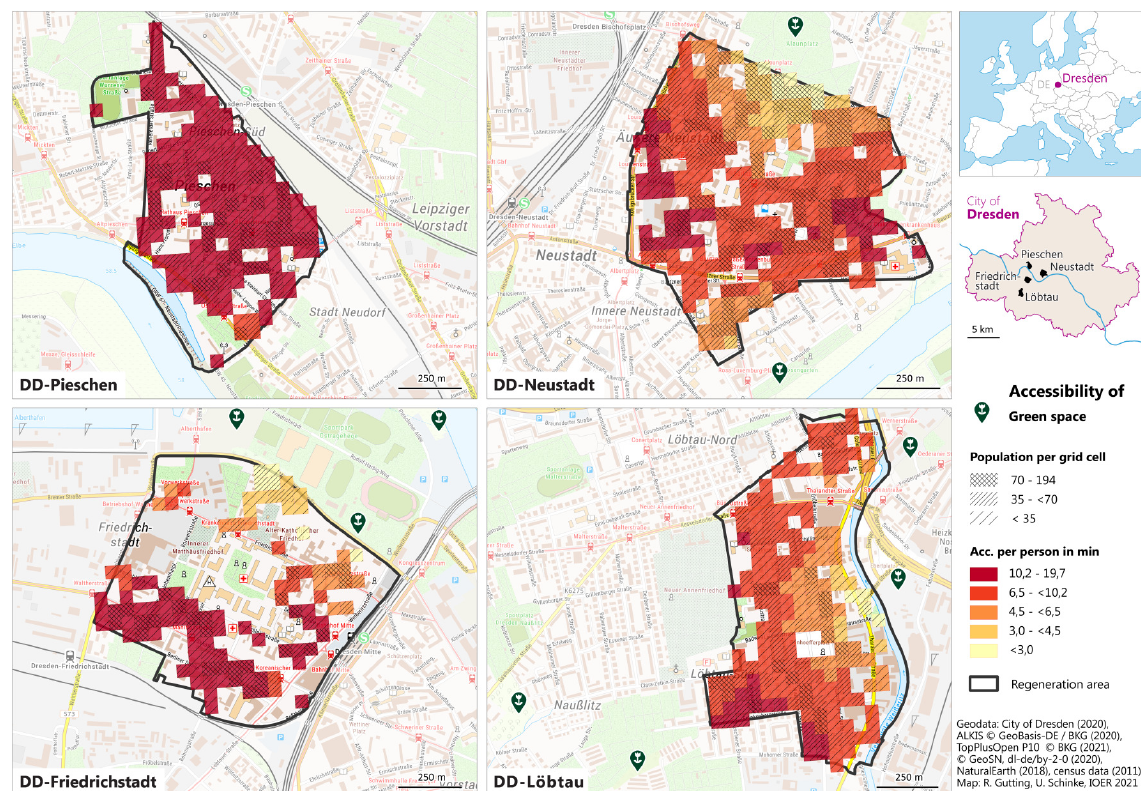
Figure 5. Grid cells showing population density and walking distance in minutes to nearest green space.